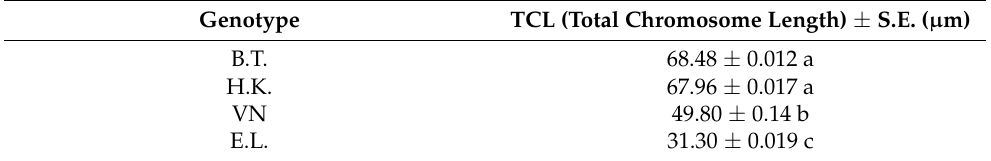
Table 5. Mean comparison of different P. vulgaris L. genotypes studied.